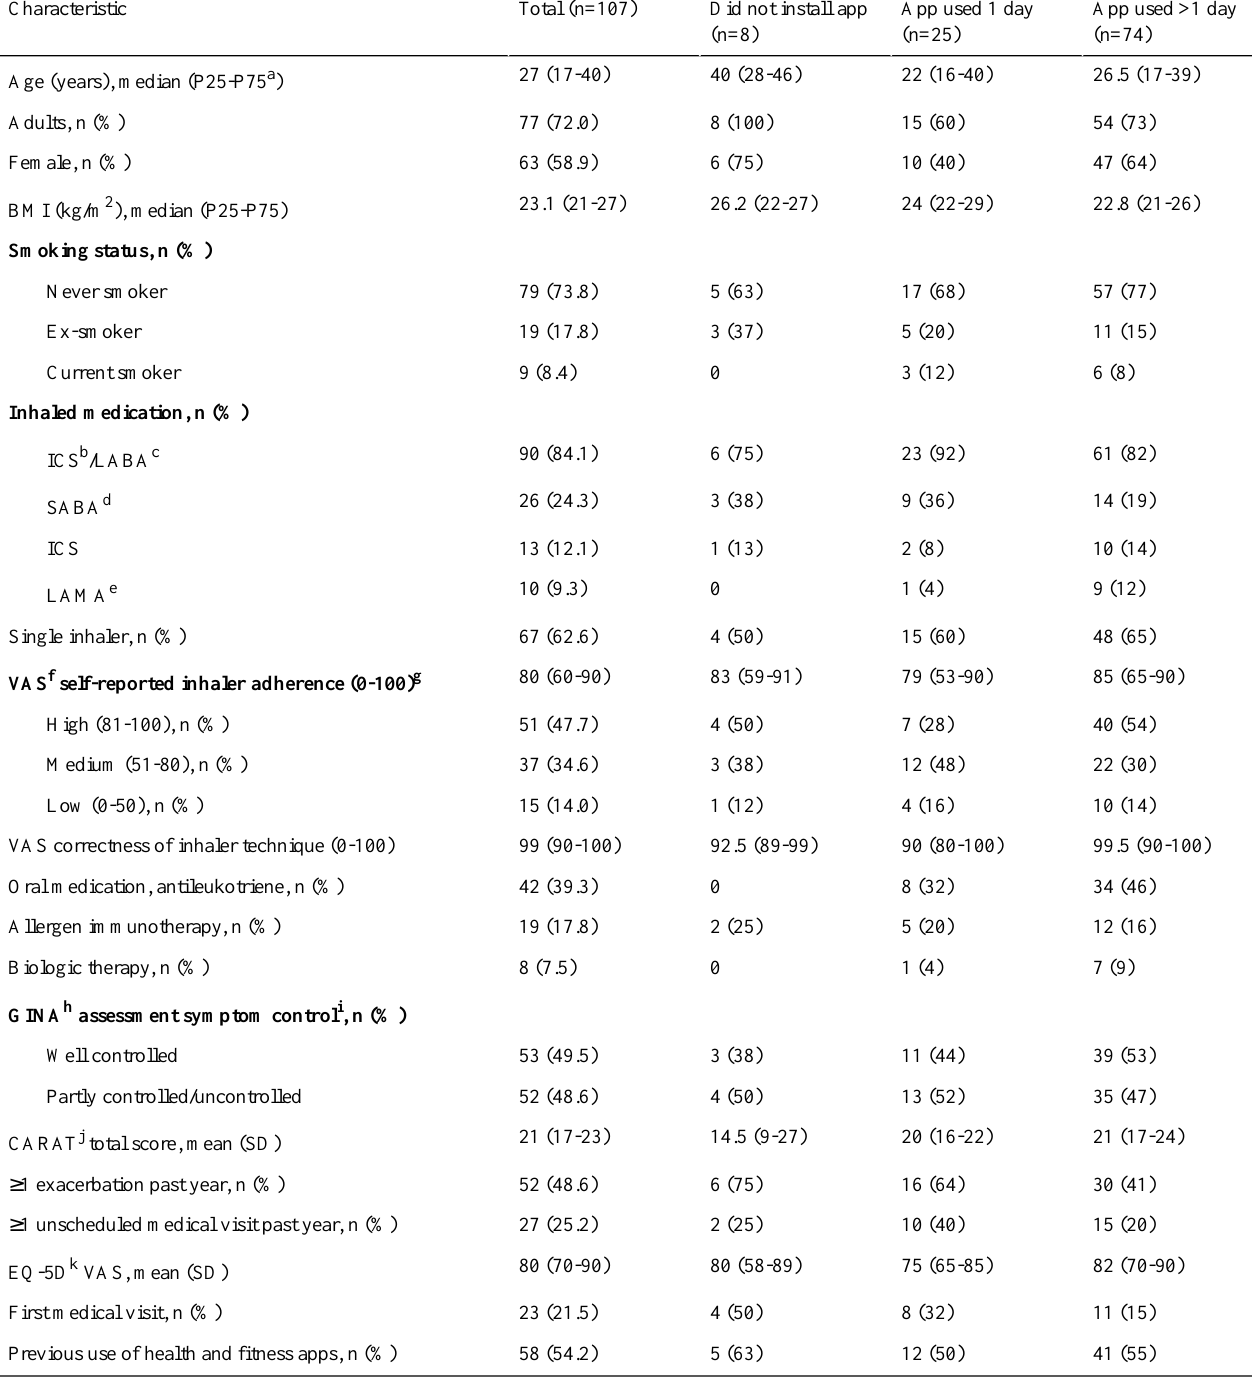
Table 2. Participant baseline characteristics